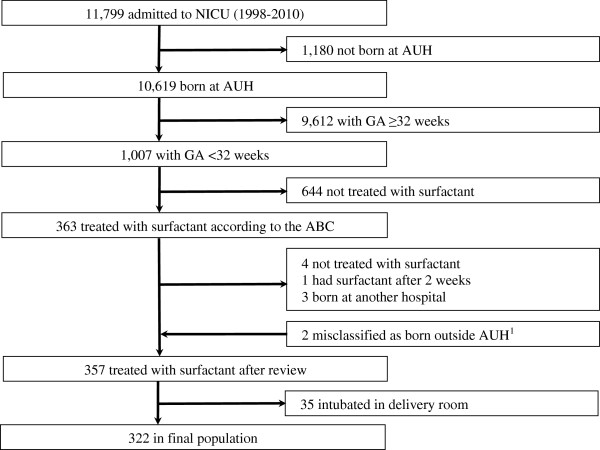
Study population. Abbreviations: AUH, Aarhus University Hospital; GA, gestational age; NICU, neonatal intensive care unit. 174 neonates were born outside AUH according to the Aarhus Birth Cohort, but fulfilled the other inclusion criteria. Two of these neonates were included as they were actually born at AUH.